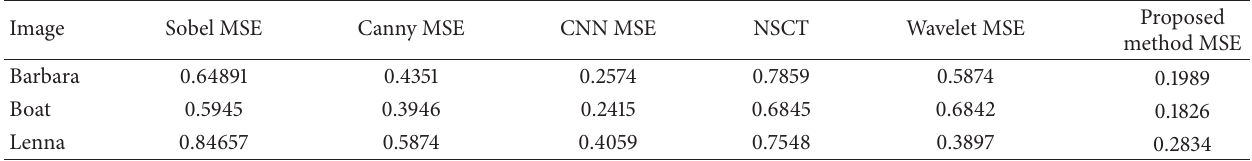
Table 3: MSE of the different detection